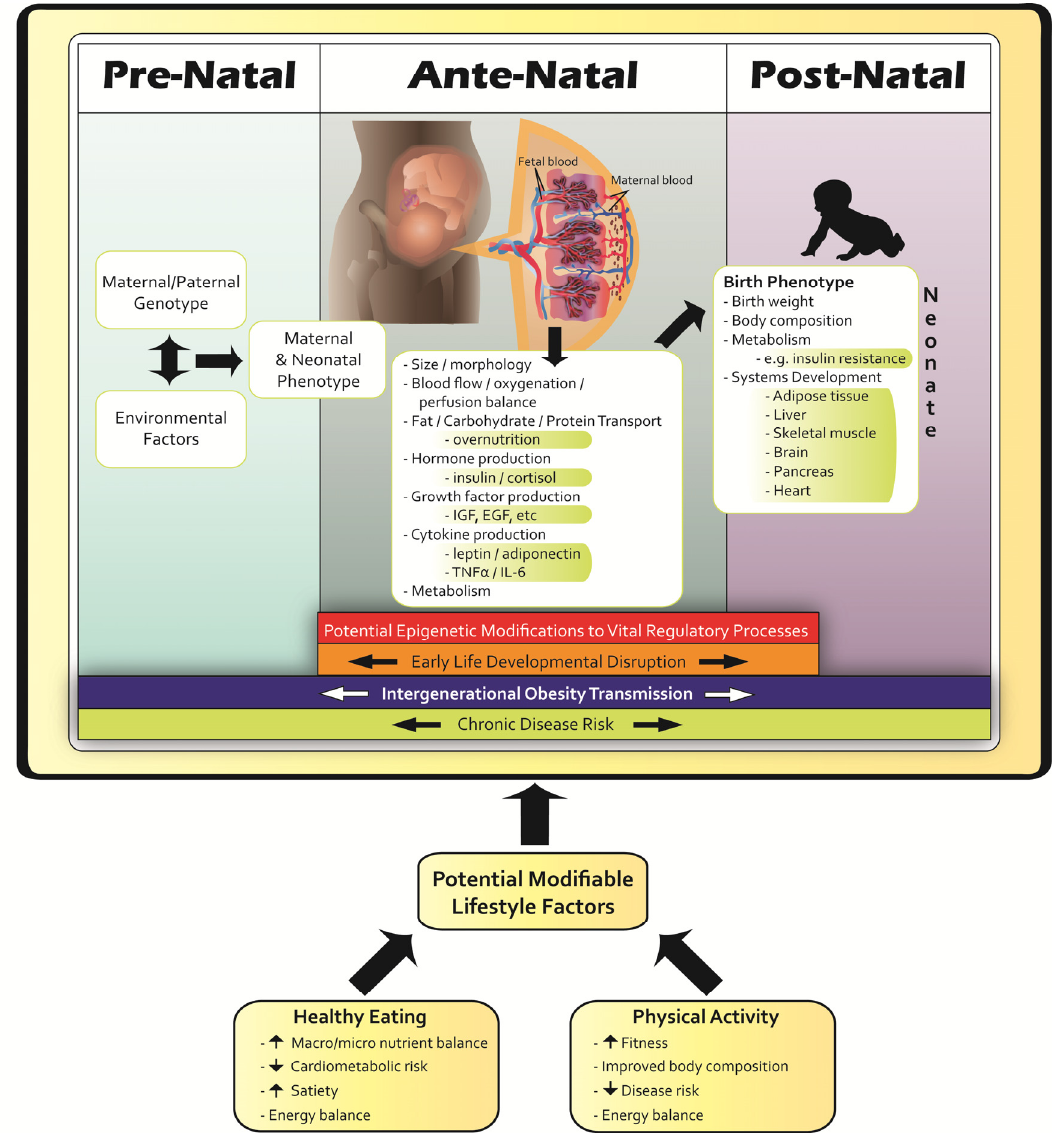
Figure 6. Complex relationships and potential role of various contributors to downstream